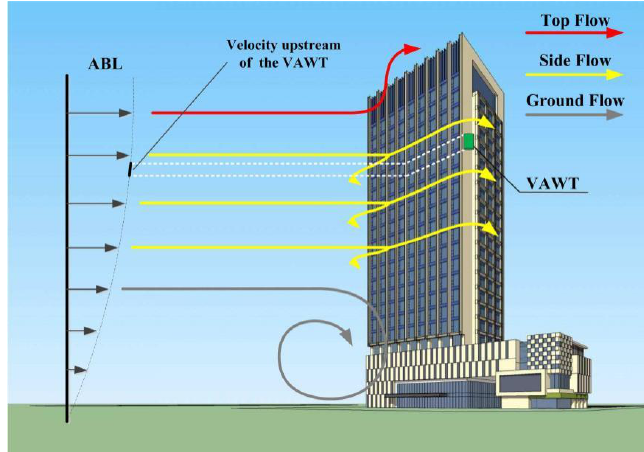
Figure 1. A schematic of a VAWT mounted on the edge of a building.